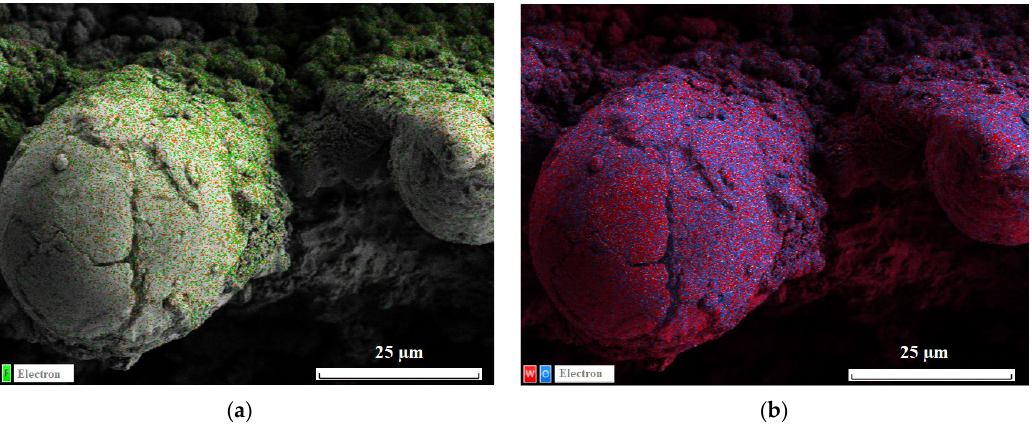
Figure 5. EDS elemental maps for the distribution of ( a ) carbon (orange dots) and fluorine (green); ( b ) tungsten (red) and oxygen (blue) on the surface of superhydrophobic tungsten sample obtained by regime 13 after 10 h of oscillated sand abrasion test.